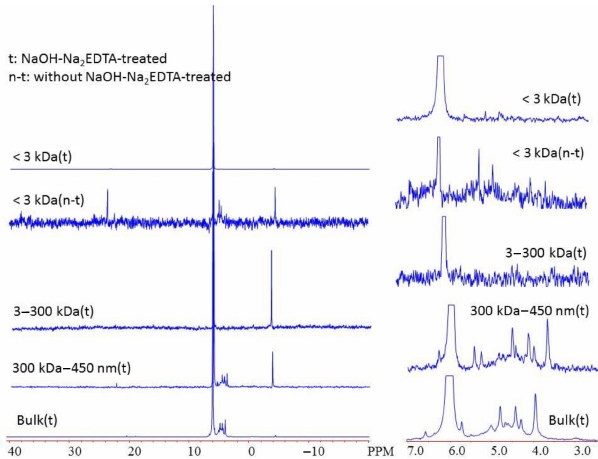
Figure 3. Solution phosphorus-31 nuclear magnetic resonance spectra of NaOH–Na 2 EDTA extracts of bulk soil, 300kDa–450nm, 3–300kDa, and < 3kDa fractions in soil water extracts < 450nm